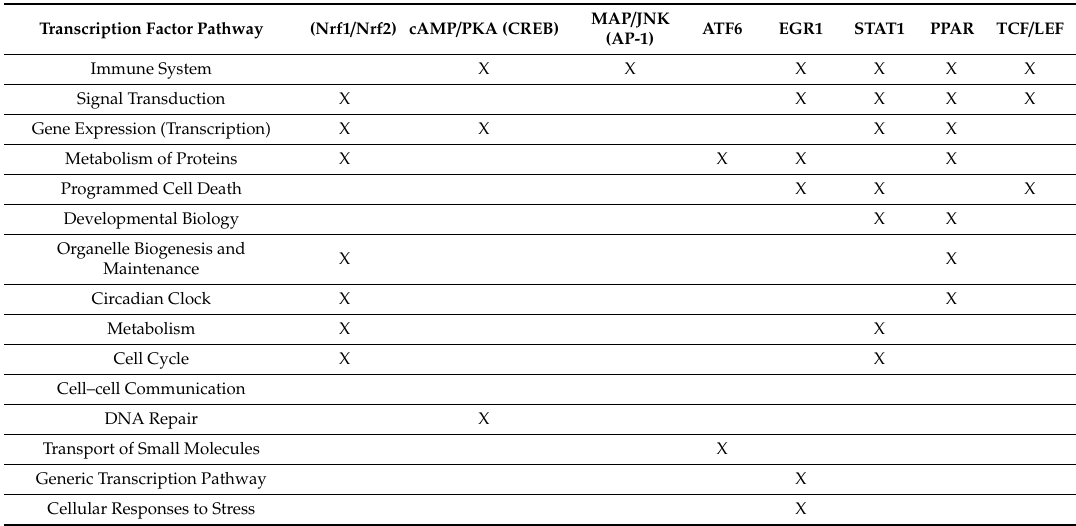
Table 2. Transcription factor pathway analysis. Each transcription factor that was significantly regulated by zinc is mapped to the various transcription factor